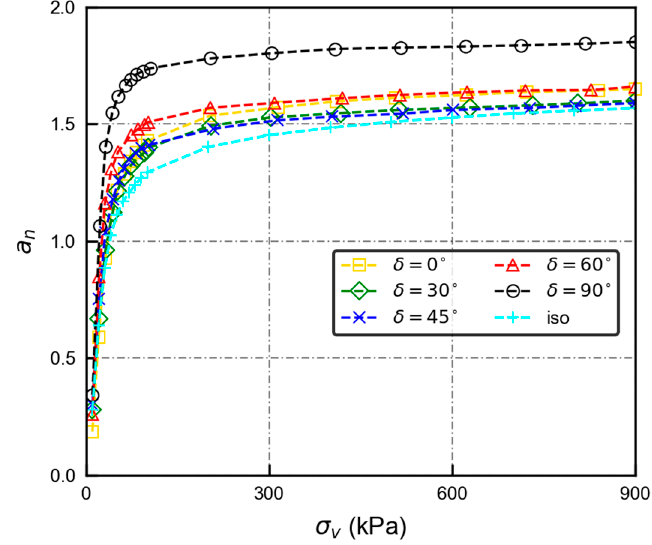
Figure 11. Evolution of a n in different initial anisotropy specimens.